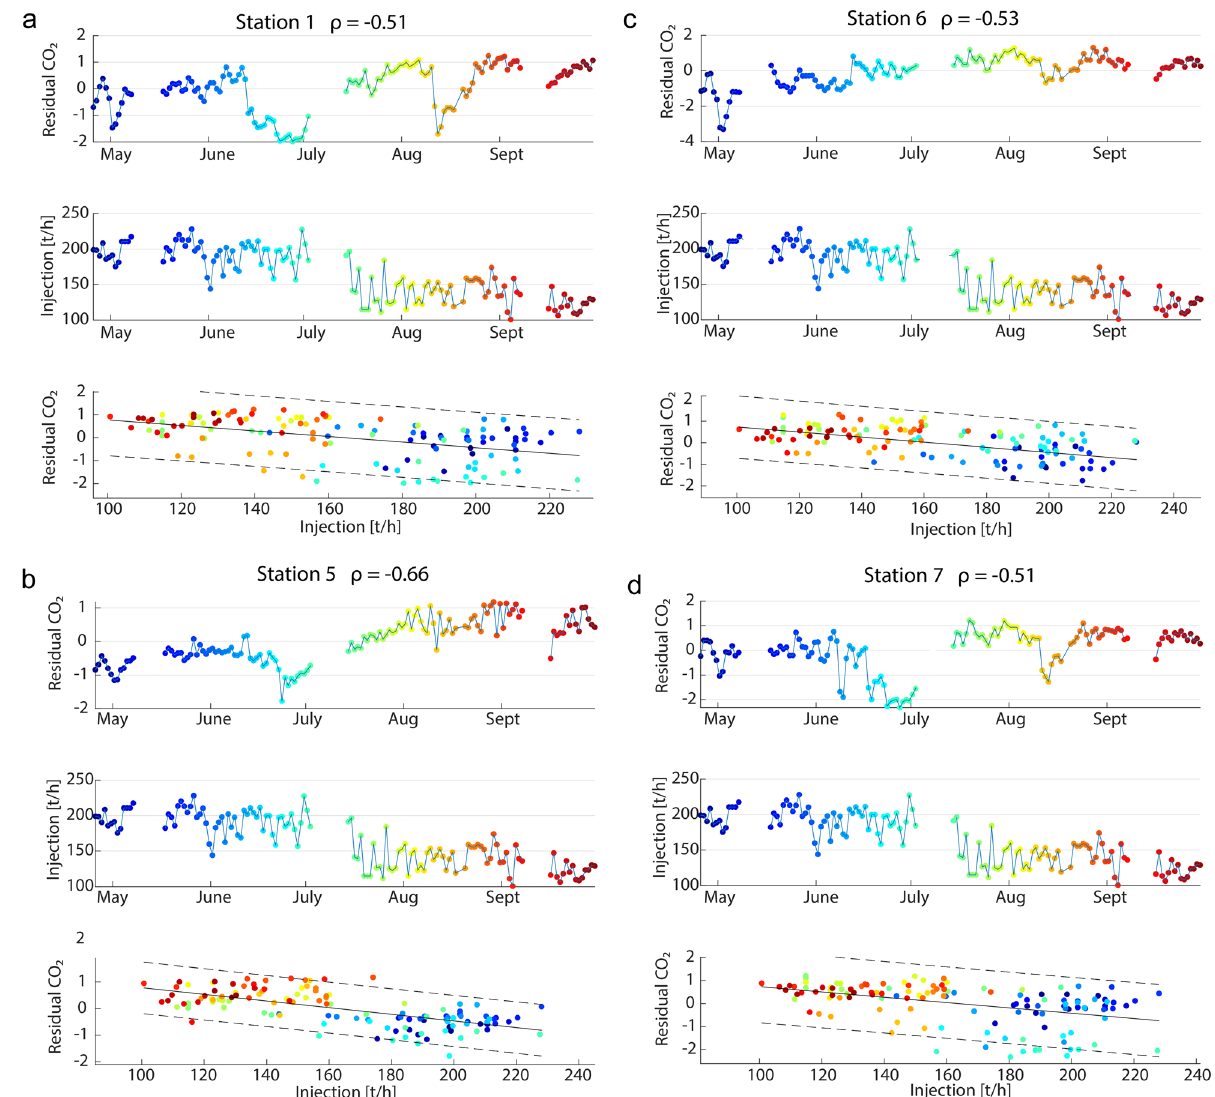
Figure 5. Temporal relationship between daily residual CO 2 flux (upper plot) and total reinjected fluids (middle plot) at: ( a ) station 1, ( b ) station 5, ( c ) station 6, and ( d ) station 7 and corresponding spearman correlation coefficients (ρ). Linear regression analysis (bottom plots) illustrates the relationship between the CO 2 flux residuals and reinjection rates within the 95% confidence interval. Colours are used to visualize the data of the respective time periods . The interrupted lines in the CO 2 flux and reinjection curves represent data gaps that are not considered in the determination of correlation